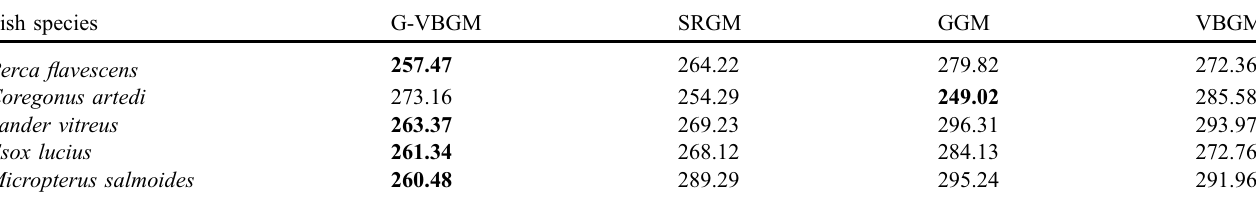
Table 5. Deviance information criterion (DIC) values for the four growth models (G-VBGM, SRGM, GGM and VBGM) used in this study. Fish species G-VBGM SRGM GGM VBGM Perca fl avescens